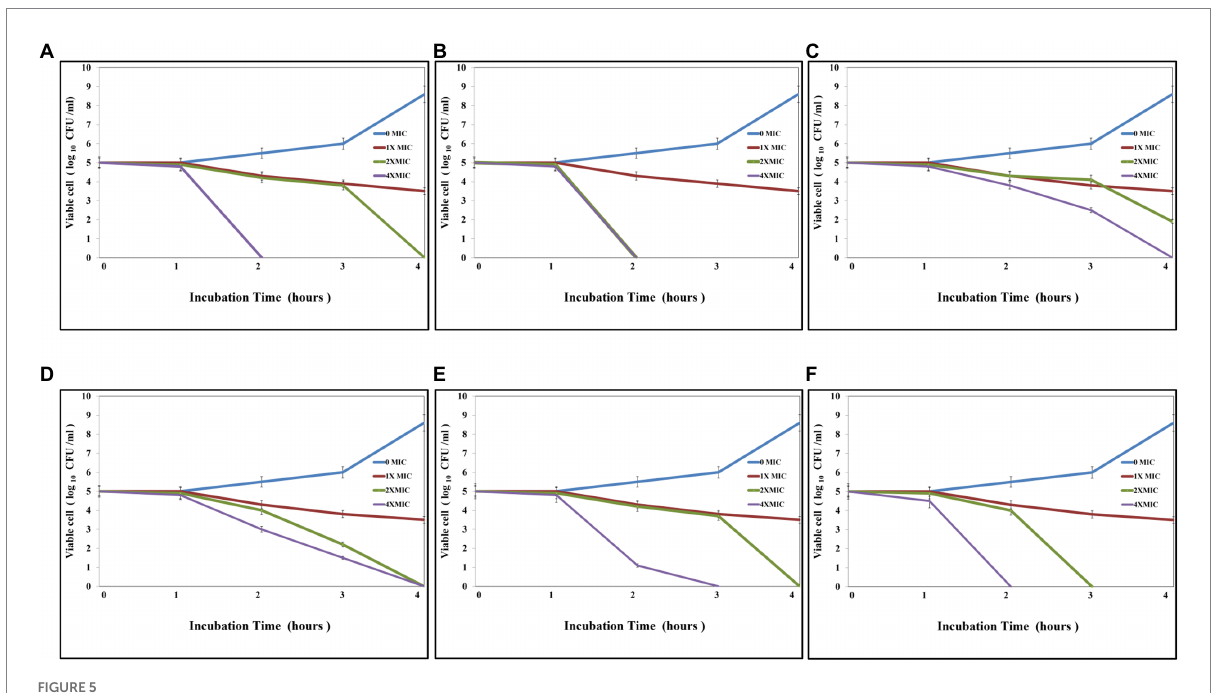
FIGURE 5 Kill time assays: (A) Silver magnetite core shell nanoparticle against Escherichia coli . (B) Silver magnetite core shell nanoparticles against Salmonella typhimurium . (C) Magnetite nanoparticles against E. coli . (D) Magnetite nanoparticles against S. typhimurium . (E) Silver nanoparticles against E. coli . (F) Silver nanoparticles against S. typhimurium.